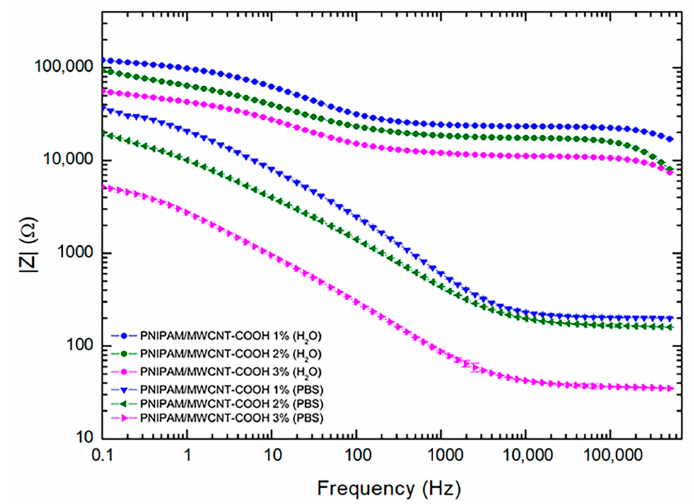
Figure 10. Log-log plot of the impedance modulus of PNIPAM/MWCNT-COOH composite hydrogels with 1, 2, and 3 wt% of filler hydrated in pure water (circles) and in PBS solution (squares). Data points represent mean values (n = 10) ± standard deviation. Where not visible error bars are smaller than symbols.